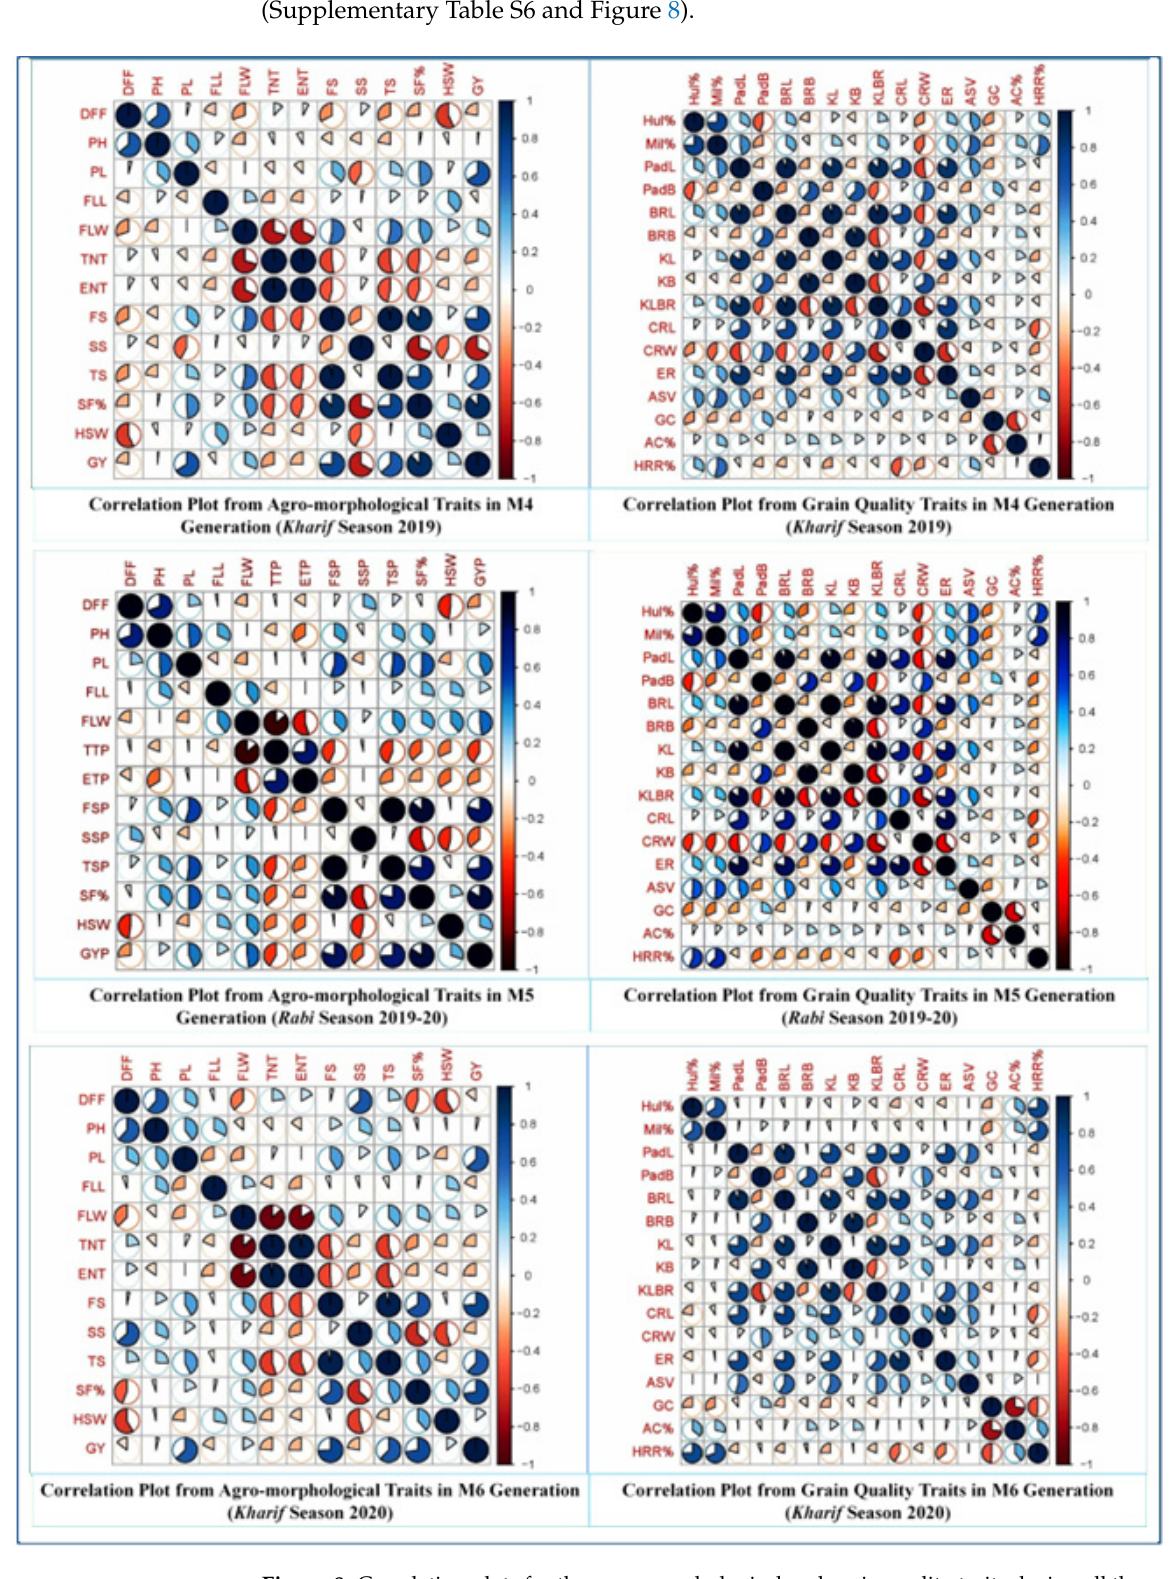
(Supplementary Table S6 and Figure 8).